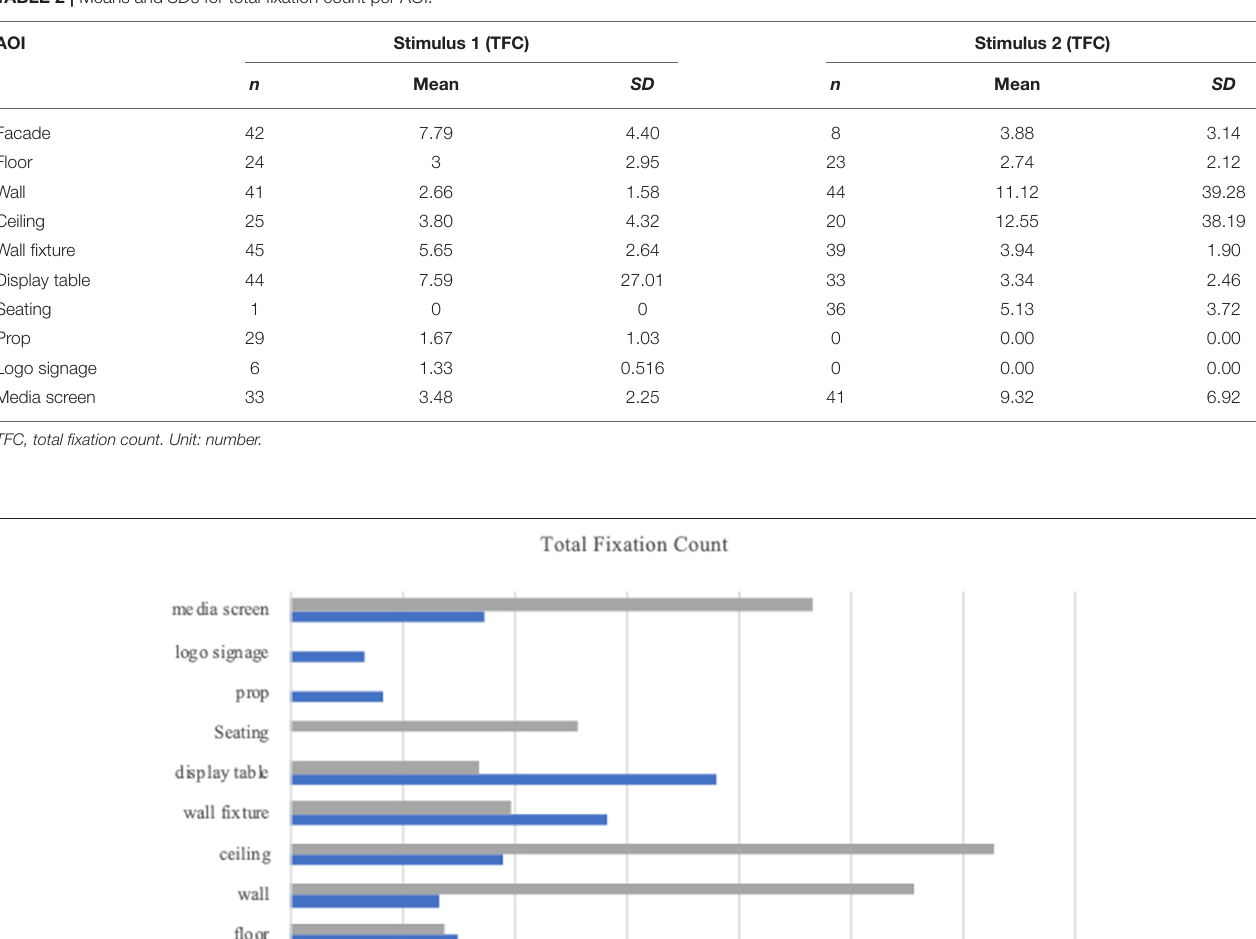
TABLE 2 | Means and SD s for total fixation count per AOI.